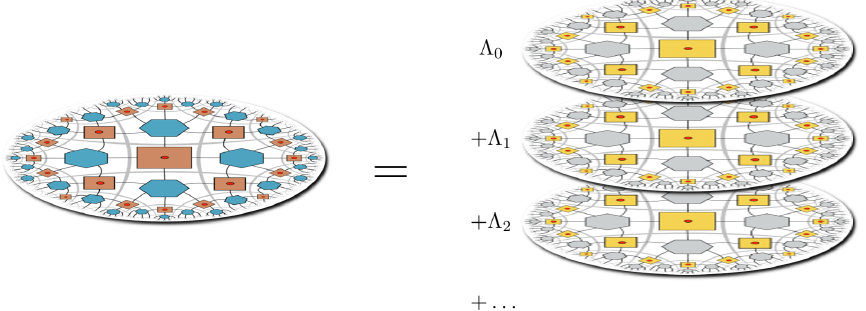
Figure 33. The skewed hybrid tensor network (left) can be thought of as a “super tensor network”. It is a superposition of exact hybrid tensor networks, but each network can have a different set of stabilizers and gauge operators, hence pushing rules. The skewed tensors are coloured in blue or brown whereas the exact ones are coloured yellow or grey. This decomposition is non-unique, and the tensor network in each term of the superposition need not be the